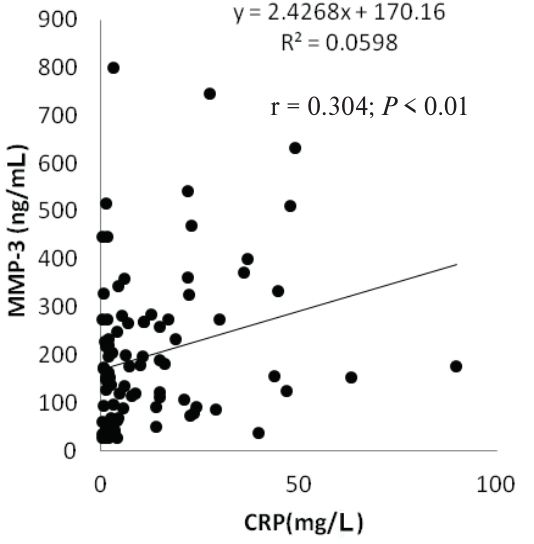
Fig. 2. MMP-3 serum levels in anti-CCP negative and anti-CCP positive RA patients. Box shows the distance between the quar- tiles, with the median as a line, and the whiskers show minimum and maximum values of MMP3. Outliers are shown as separate points. The P-value show statistical significance of differences between groups.